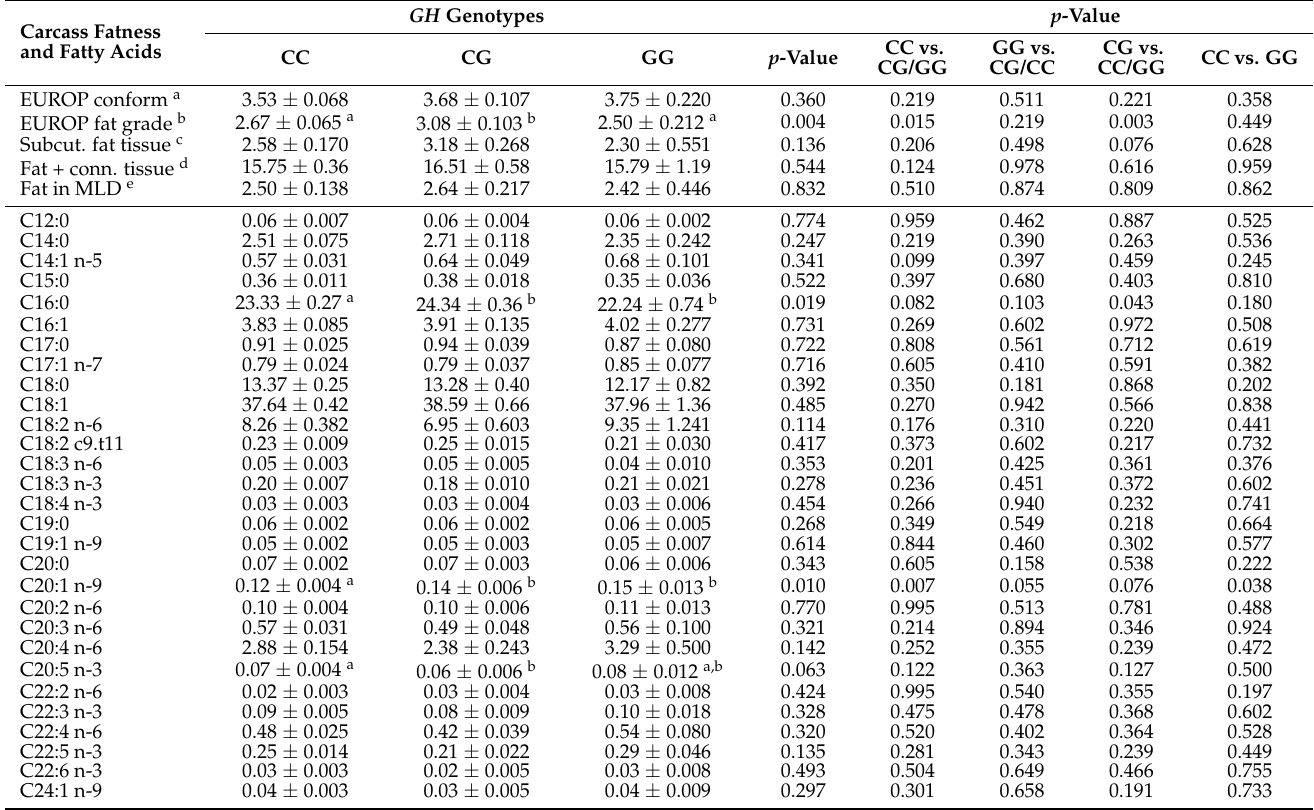
Table 5. Carcass fatness and fatty acid content in MLD , their sums and ratio by GH genotypes (LS Mean ± SE and p